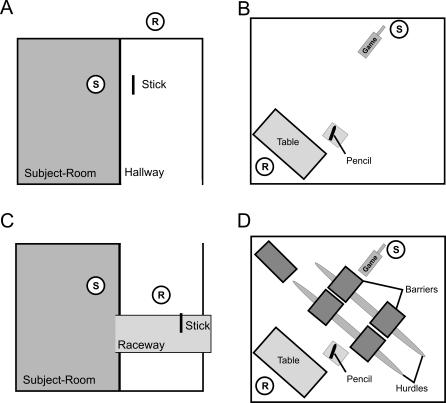
Test Areas and Setup for Chimpanzees and Human ChildrenExperiment 1 (A, B) and experiment 2 (C, D) are shown. S indicates the subject and R indicates the recipient. The target object (chimpanzees: stick; children: pencil) was placed out of reach for the recipient but was accessible by the subject. The measured target behavior was whether the subject helped by picking up the object and handing it to the recipient.